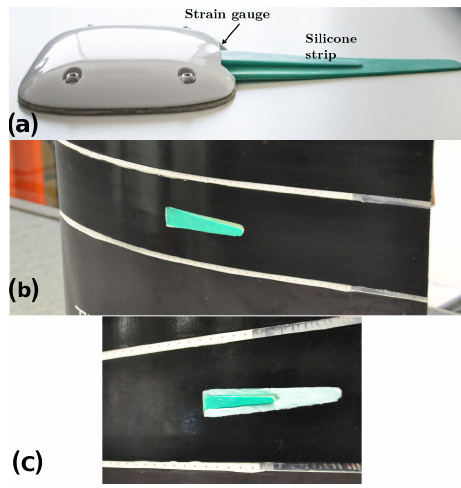
Figure 4. Picture of the innovative e-TellTale sensor ( a , shell and long-strip cases of Table 1; b , no-shell and long-strip cases of Ta- ble 1; c , TENSS case of Table